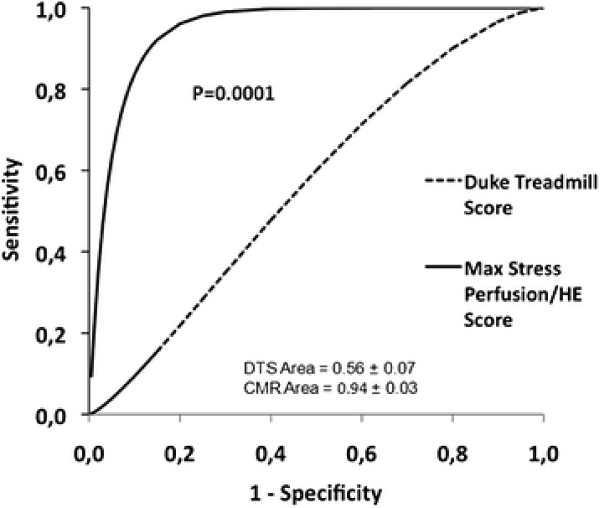
Receiver-Operator Characteristic Curves. Receiver-operator characteristic curve analyses comparing CMR and the Duke Treadmill Score for the detection CAD in all patients. The diagnostic accuracy of CMR was significantly greater than the Exercise ECG even when considering the Duke Treadmill Score (P = 0.0001). AUC = area under the curve.